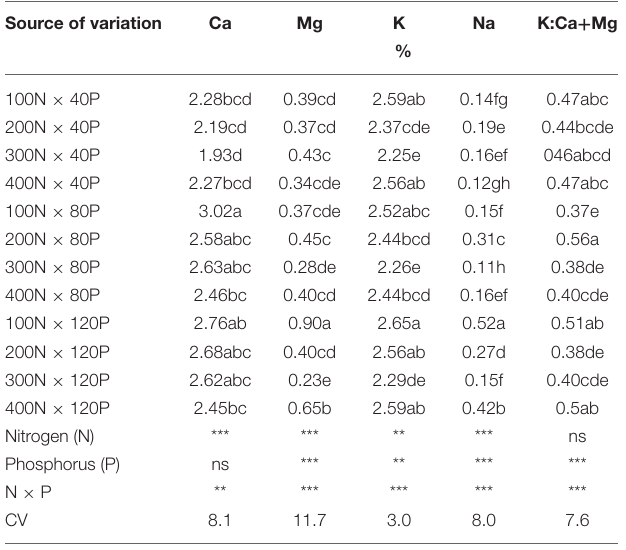
TABLE 5 | Effect of nitrogen: phosphorus combinations on concentrations of phosphorus (P), Zinc (Zn), copper (Cu), manganese (Mn), and iron (Fe) in moringa